Question: What direction does the quantity move in — increasing or decreasing?
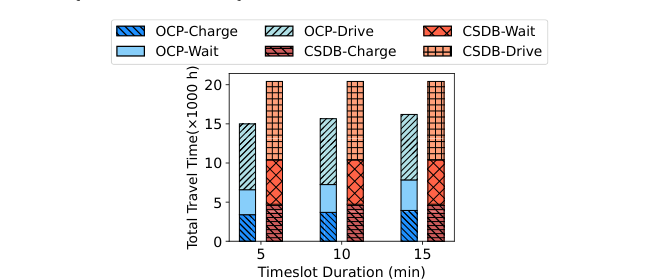
Answer: increasing